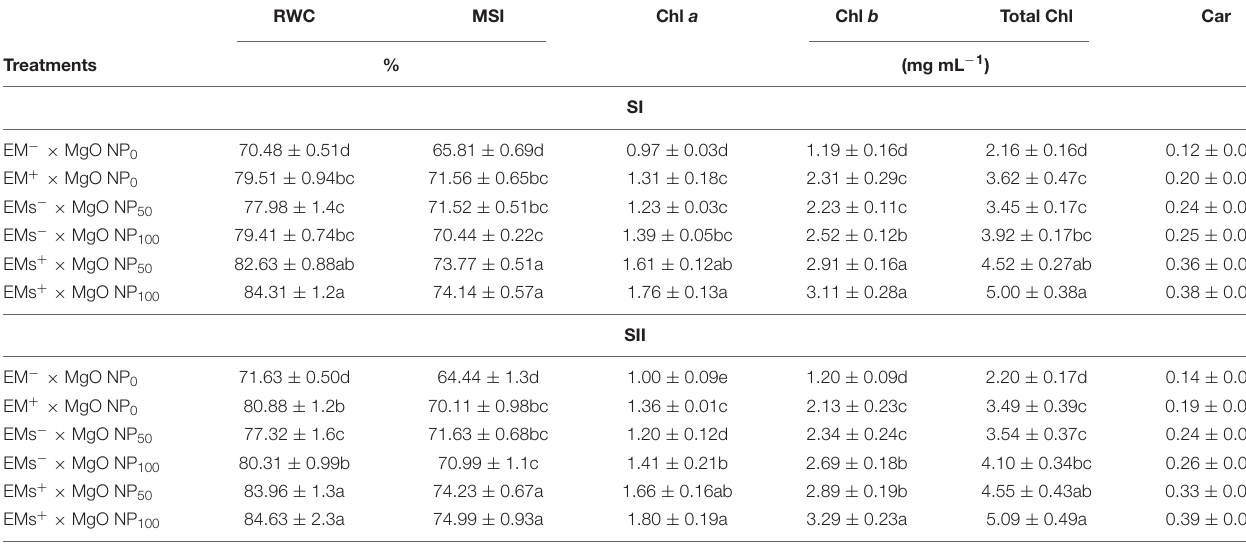
TABLE 4 | Effect of foliar application with magnesium oxide (MgO) nanoparticles (MgO-NP) and effective microorganisms (EMs) on the concentrations of leaf photosynthetic pigments and plant water status of sweet potato ( Ipomoea batatas L.) grown in salt affected soil in 2020 (SI) and 2021 (SII) seasons. RWC Car